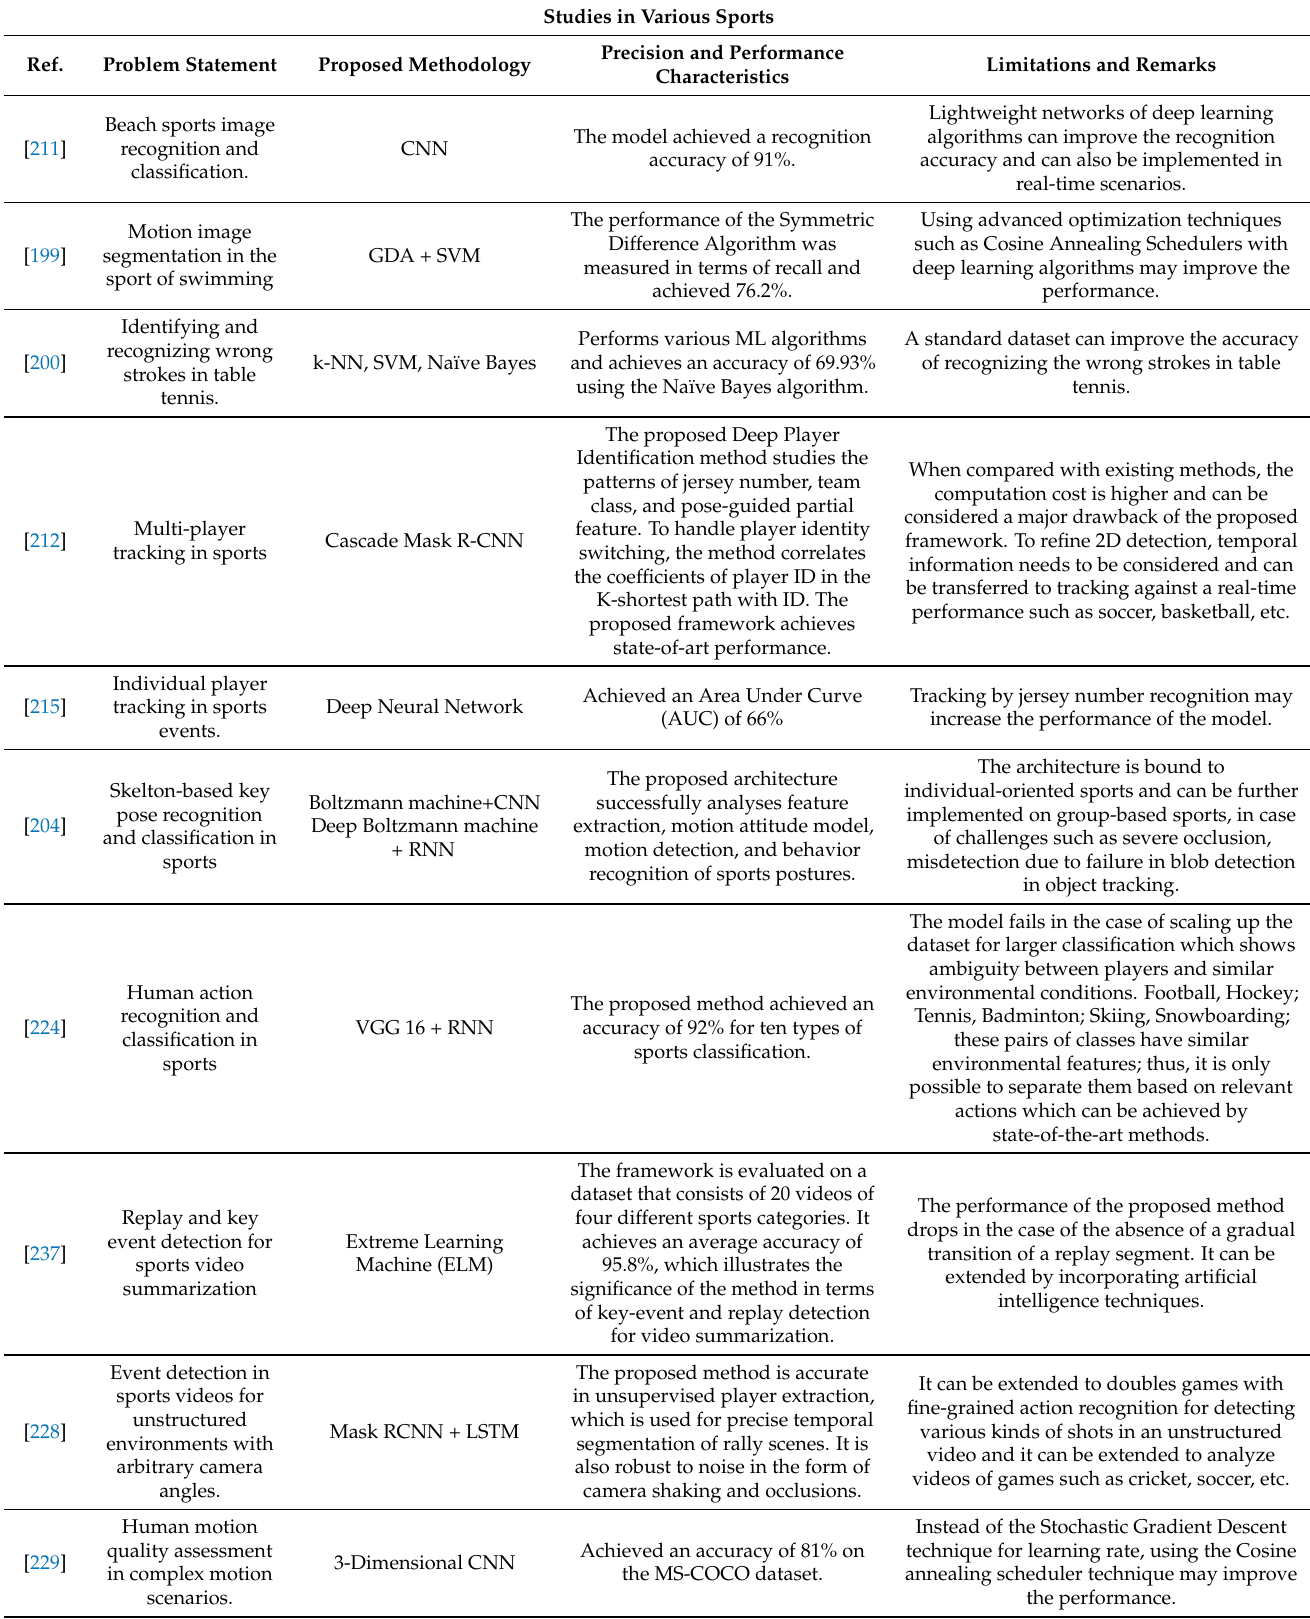
Table 9. Studies in various